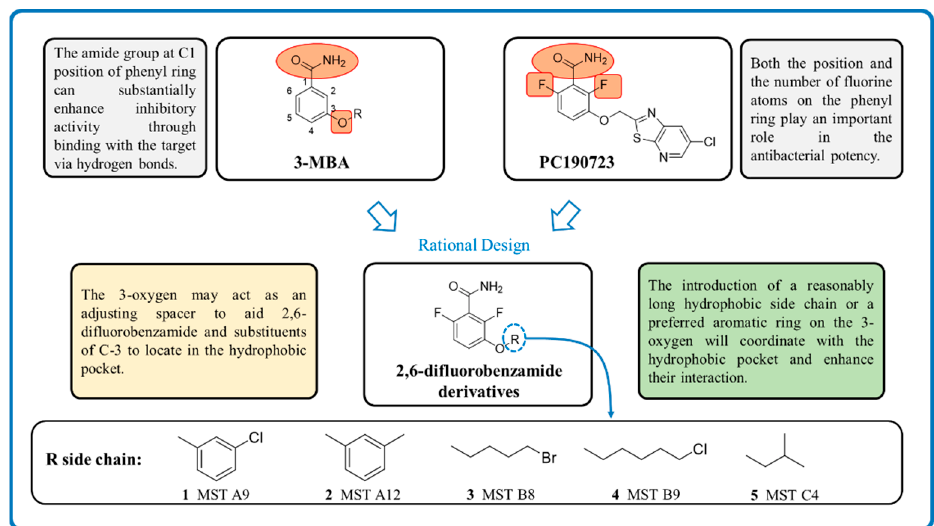
Figure 1. Design strategy of the novel 2,6-difluorobenzamide derivatives described previously for compounds MST A9 ( 1 ) [23], A12 ( 2 ) [23], B8 ( 3 ) [24], B9 ( 4 ) [24] and C4 ( 5 ) [24].